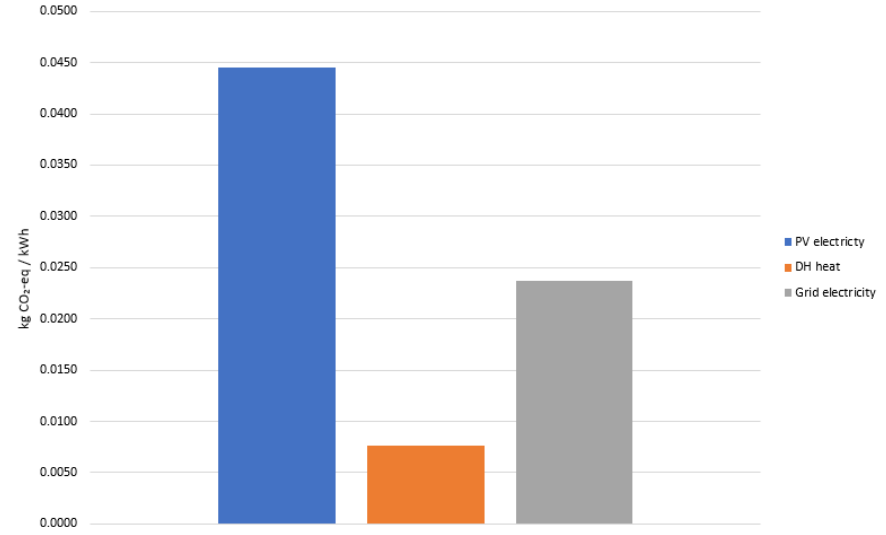
Figure 9. Comparison of emission factors between the energy sources of the Smaragd building.